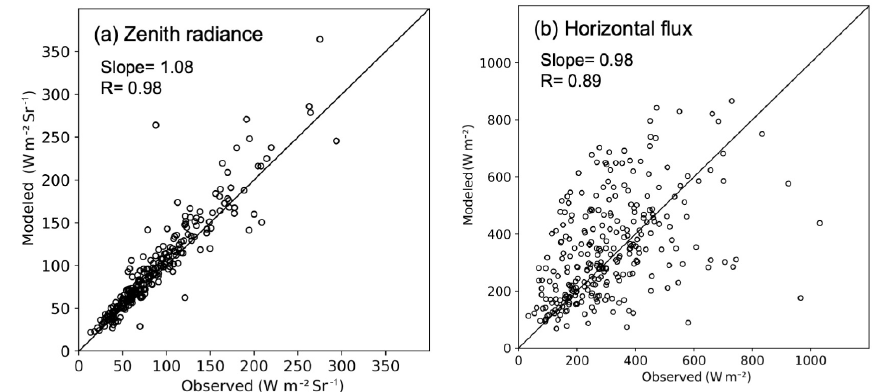
Figure 14. The same as in Fig. 13 but for the comparison between modeled and observed broadband (a) radiances and (b) horizontal radiative fluxes. Regression lines are shown with zero intercept constraint at the